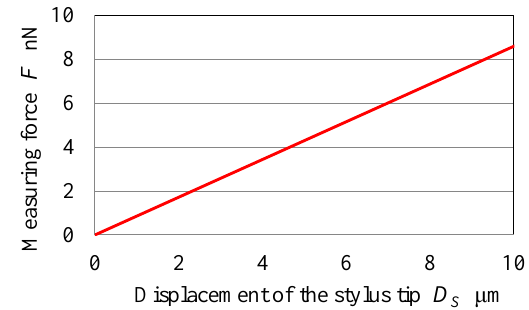
Figure 18. Measured force acting on the stylus tip (stem length: 1 mm, stem diameter: 3 µm, and ball